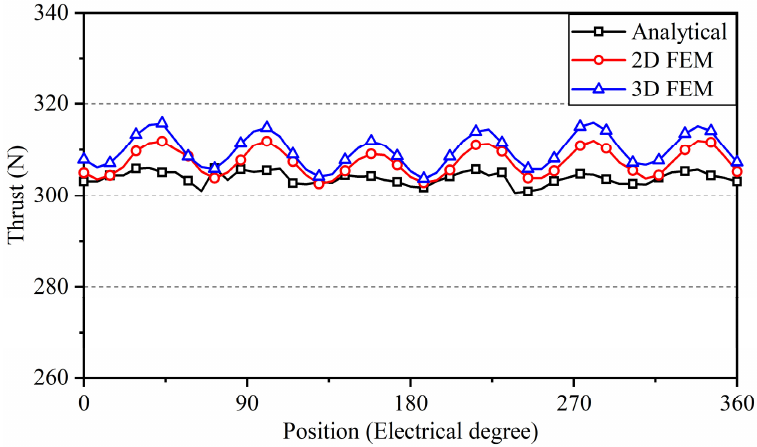
Figure 19. 3D magnetic flux density distribution map of DCB ‐ VRLM with non ‐ uniform air gap.